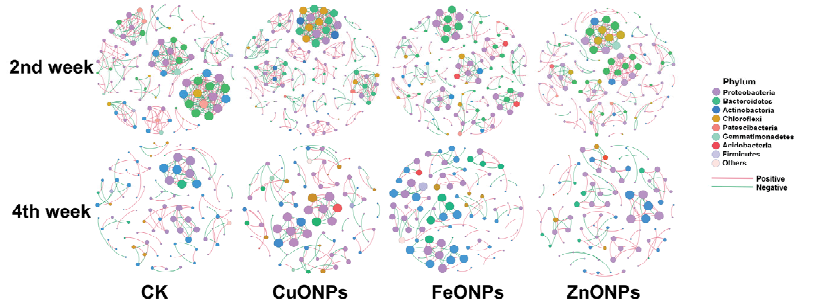
Figure 7. Effect of three metal oxide nanoparticles (CuO, FeO, and ZnO) on the co-occurrence patterns of soil bacterial community. Networks were constructed at the amplicon sequence variants (ASV) level. The size of nodes (ASVs) represents the relative abundance of microbes, and the nodes are colored according to phylum. Green lines and red lines represent negative correlation and positive